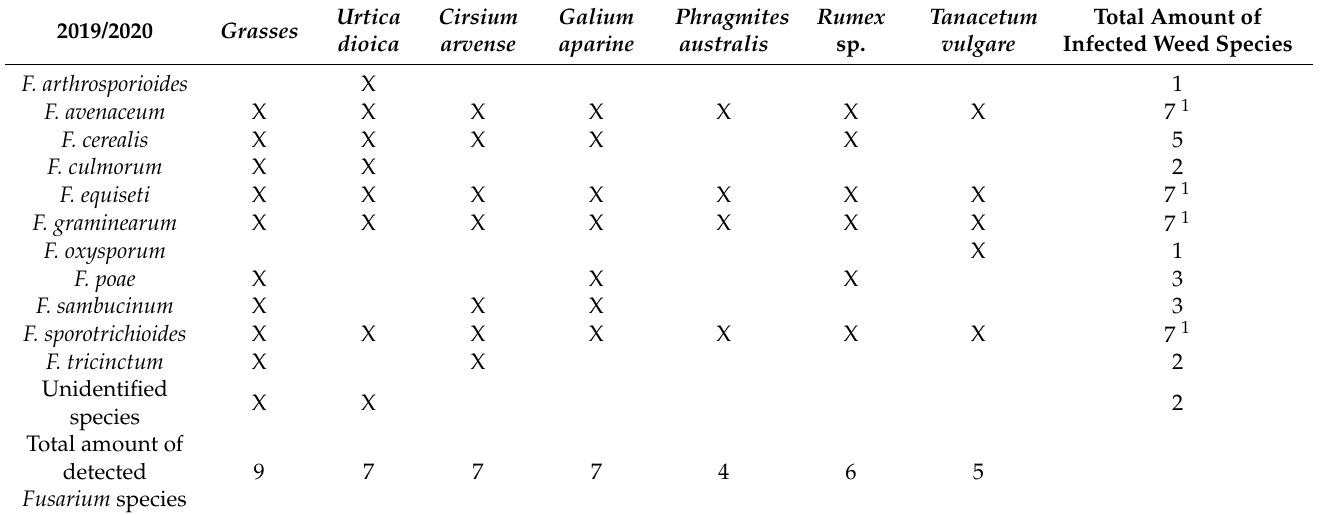
Table 4. Fusarium species isolated from all sampled plants at the edges of all kettle holes investigated in 2019/2020. Sampling months are summarized. X stands for the presence of one specific Fusarium species (11 in total, column 1) on one plant species/family (line 1). Grasses are a mixture of the species Arrhenatherum elatius , Bromus sterilis , Calamagrostis epigejos , Dactylis glomerata , Elymus repens , Lolium perenne , Poa trivialis in different proportions.